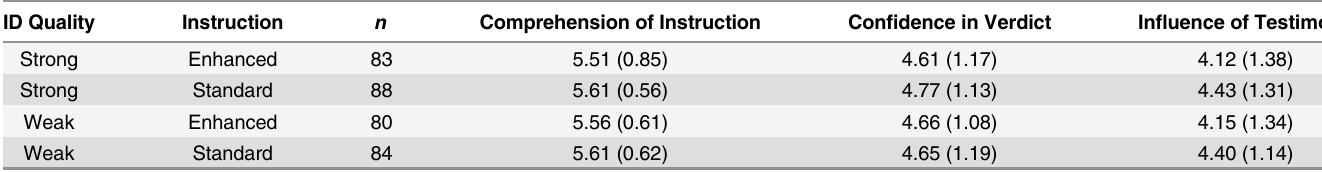
Table 3. Participant Comprehension, confidence, and